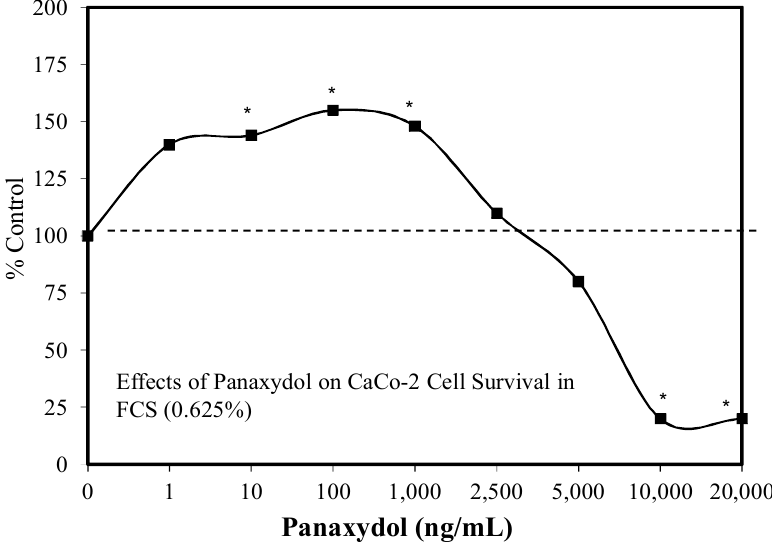
Figure 32. Effects of panaxydol on CaCo-2 cell survival in FCS (0.625%) (Source: [111]). Each * represent statistical significance for a data point.